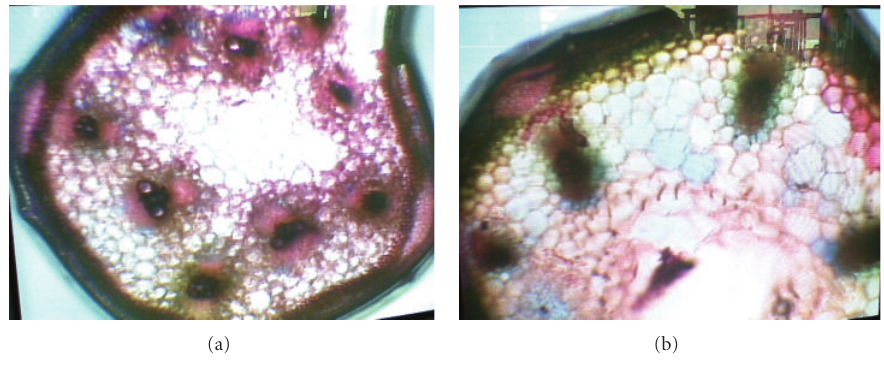
Figure 9: Comparison of stem cross-sections for (a) fresh untreated plant and (b) a plant after 15 seconds of treatment.